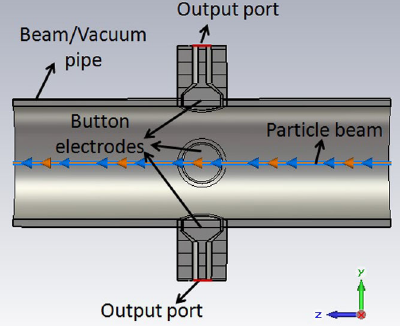
FIG. 3. CST model for the simulation of the test BPM with particle beam.